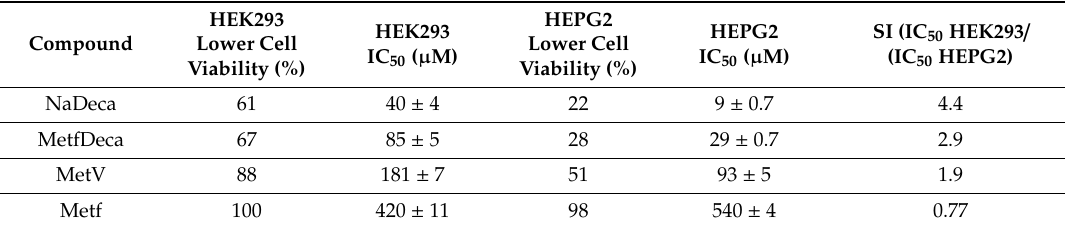
Table 2. Cytotoxic activity (IC 50 ) and selectivity index (SI) of compounds against HEK293 and HEPG2 cells after 24